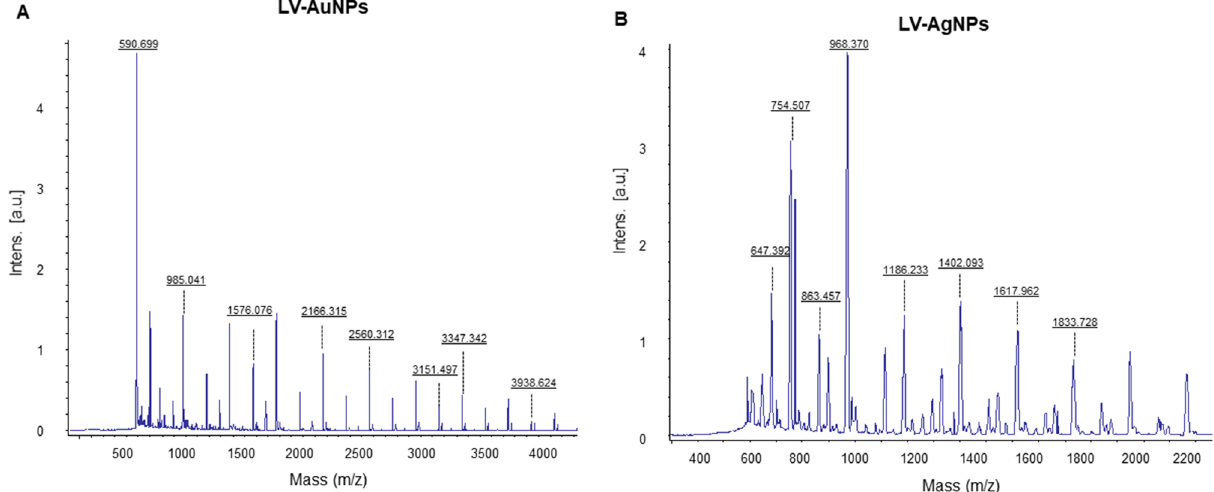
Figure 7. MALDI-TOF analysis of (A) LV-AuNPs and (B) LV-AgNPs demonstrate respective